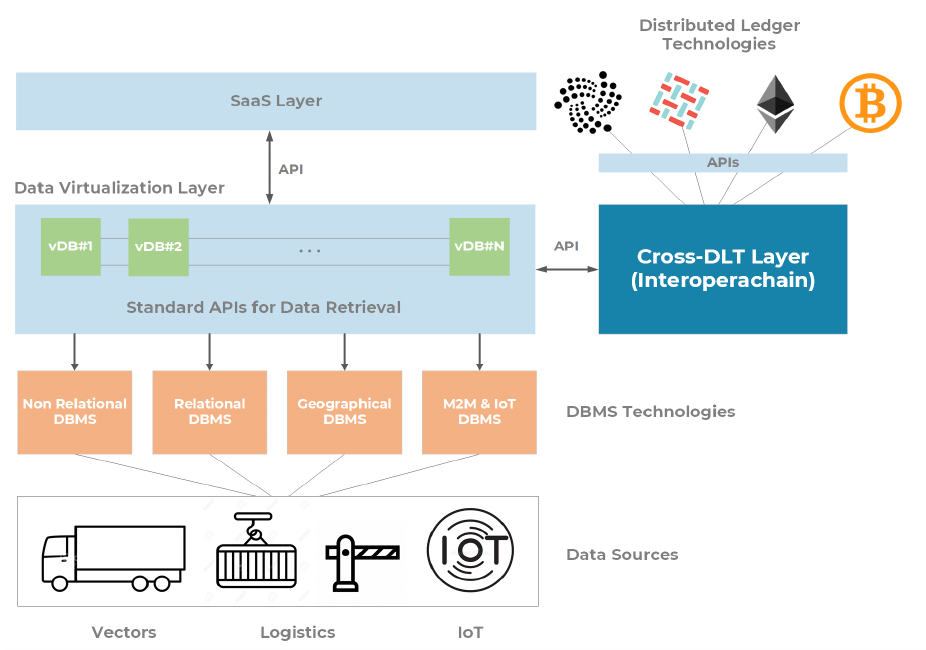
Figure 4. Data Lake implemented at the Port of